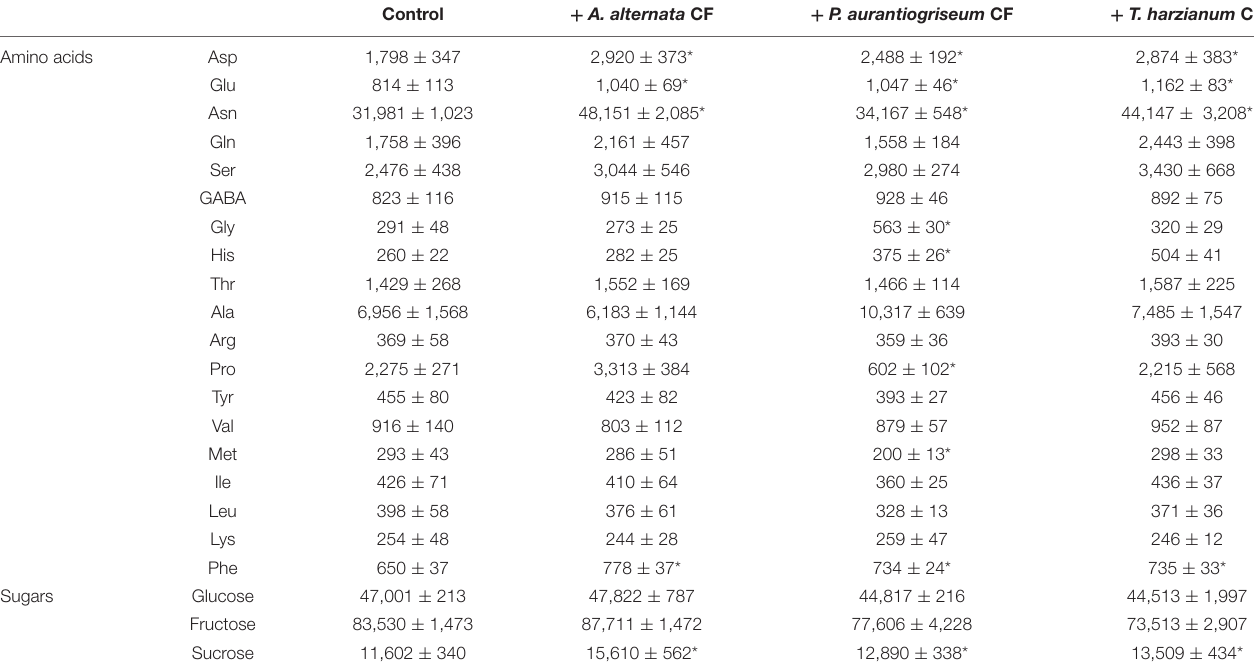
TABLE 4 | Free amino acids and sugar contents (expressed as nmol g − 1 DW) in commercial fruits of pepper plants (cv. Piquillo) cultured under open field conditions with or without drench application of fungal CFs. Control + A. alternata CF + P. aurantiogriseum CF + T. harzianum CF Amino